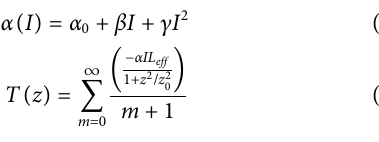
Frontiers in Materials |